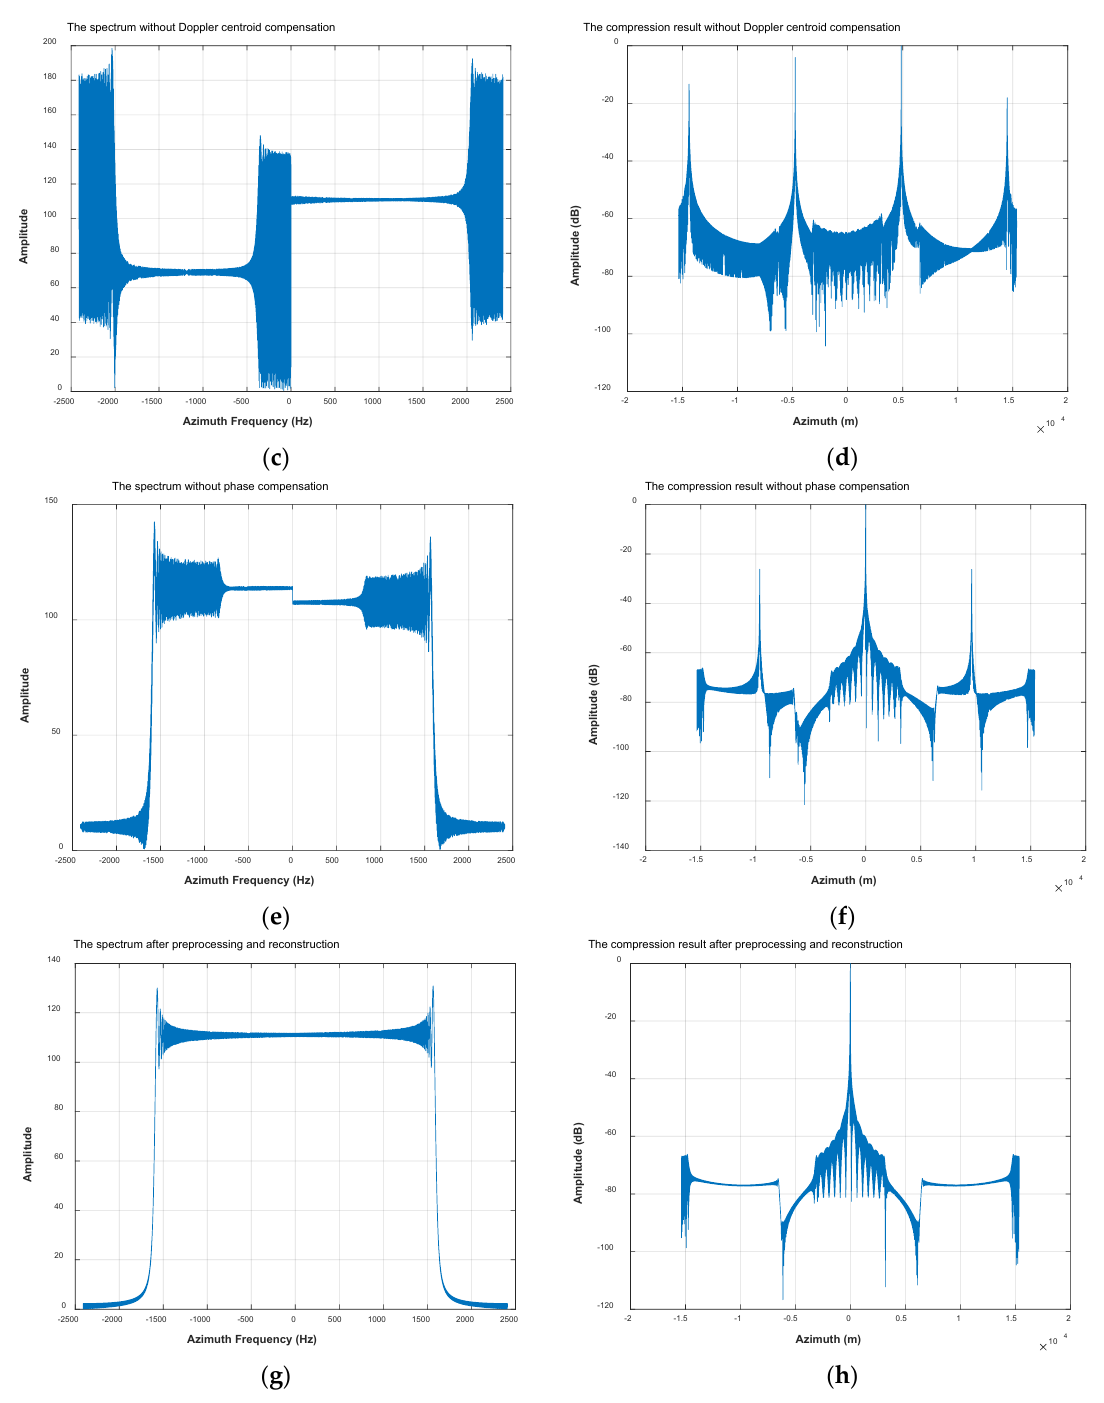
Figure 7. The result of 1D simulation. ( a ) The spectrum of SMC-SAR data that are alternatively spliced without any preprocessing or reconstruction; ( c ) The spectrum of SMC-SAR data without Doppler centroid compensation but after phase imbalance compensation and reconstruction. ( e ) The spectrum of SMC-SAR signal without phase imbalance compensation but after the Doppler centroid compensation and reconstruction; ( g ) The spectrum of SMC-SAR signal after preprocessing and re- construction. ( b , d , f , h ) correspond to the azimuth compression result of ( a , c , e , g ), respectively.